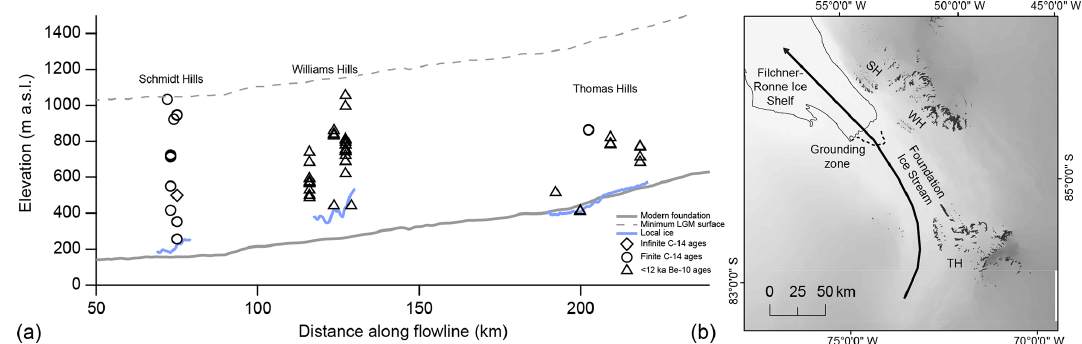
Figure 11. (a) Exposure-age results projected onto an elevation profile along flow line of the Foundation Ice Stream. (b) Flow line location is shown in the map. Infinite 14 C measurements are offset in regard to their distance along flow line to improve readability. The 10 Be data included are those from Balco et al. (2016) and Bentley et al. (2017) which yield exposure ages below 12ka (LSDn scaling, antarctica.ice- d.org). Elevation data for ice surfaces and map shading are sourced from the Reference Elevation Model of Antarctica (REMA; Howat et al., 2019). Local ice margins are highly simplified. Grounding line positions are sourced from the MEaSUREs program V2 (Rignot et al., 2011, 2014, 2016). Minimum LGM surface is the modern-day surface profile with the elevation increased above present using our minimum LGM thickness